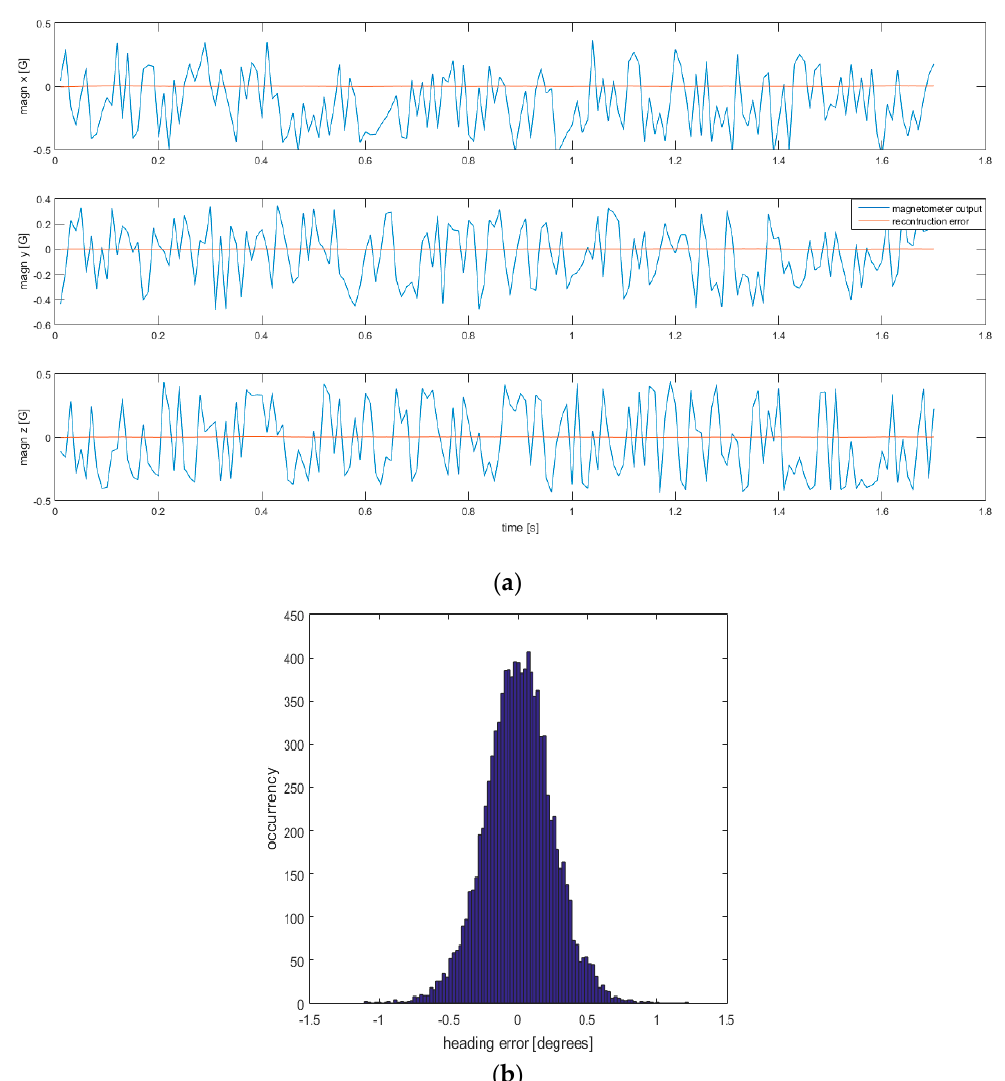
Figure 2. ( a ) In Figure 2a the simulated magnetometer outputs and the residuals are plotted in blue and red respectively along x, y, z -axes. The error has the same mean and standard deviation along all the simulated experiment (120 s) and therefore only the first 1.7 s are reported here; ( b ) histogram of the heading error.